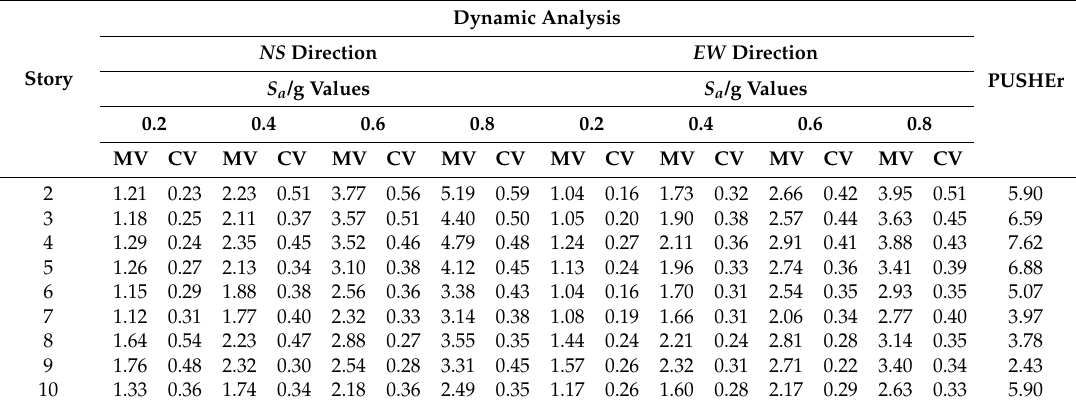
Table 7. Statistics for µ S , 10-level building.